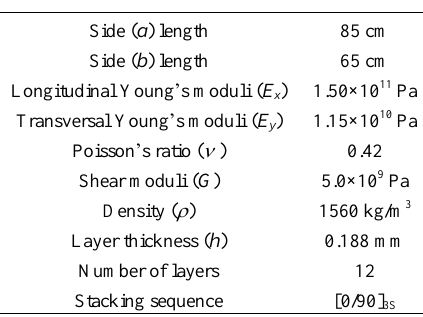
Properties of the CFRP plate